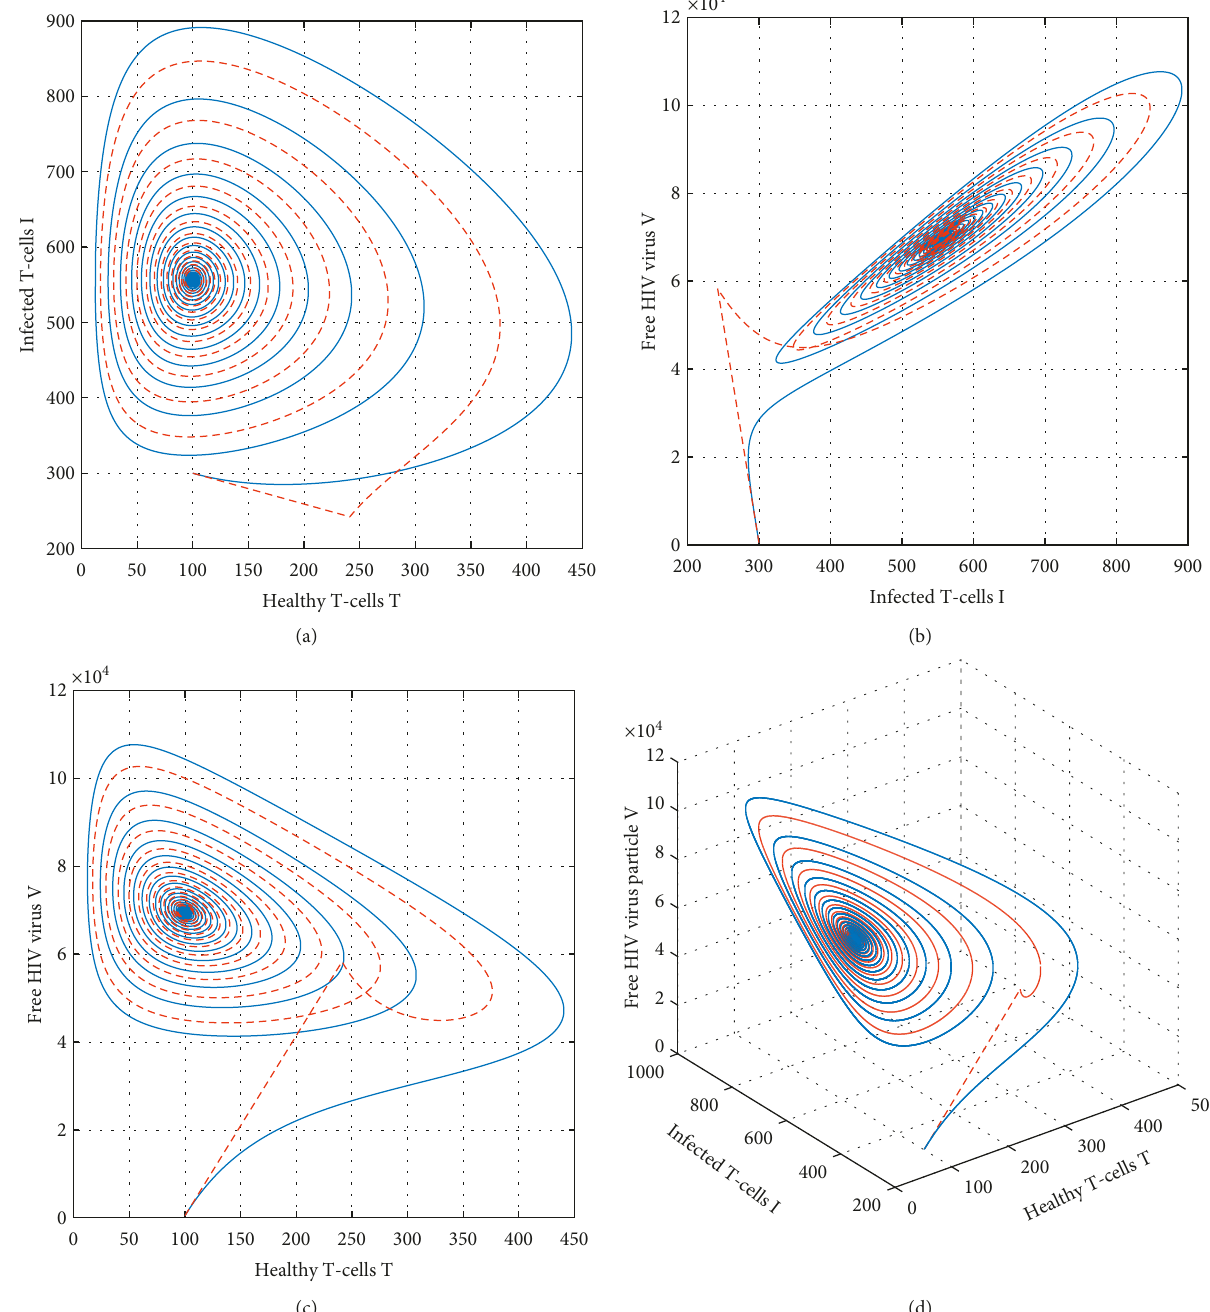
Figure 5: Graphical view analysis of the dynamical behaviour of the fractional model (2) to represent its chaotic plot with the index of memory ϑ � 0 .